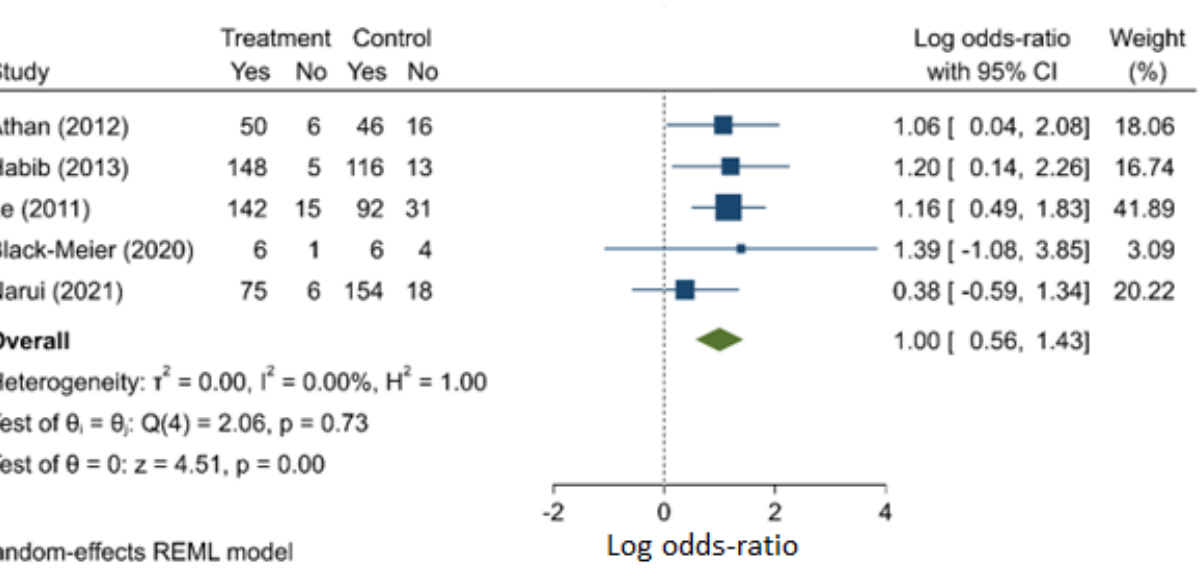
Figure 2. Staphylococcus aureus compared with non- Staphylococcus aureus CIED infection as a risk factor for mortality.